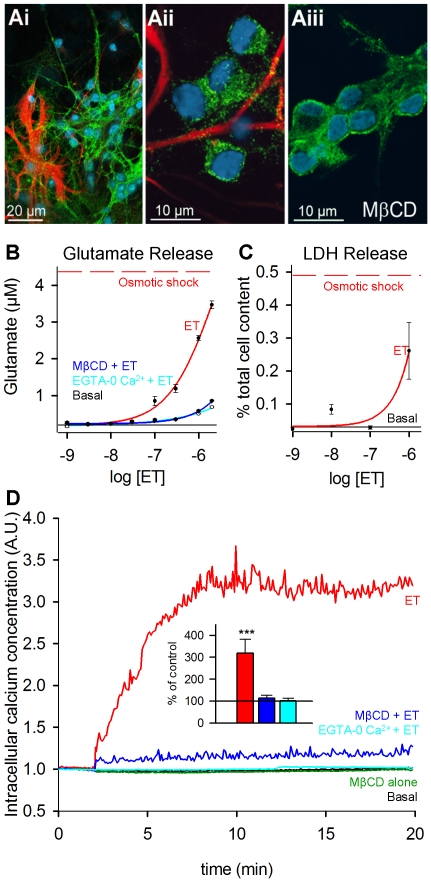
Effect of ET on primary cultures of cerebellum highly enriched in granule cells.Ai, Aii and Aiii, primary cultures of cerebellar cells. Ai and Aii, 10−7 M ET was applied in PBS buffer (i.e. containing no Ca2+ ions) for 5 min after fixation of the cells, then the ET- (green) and GFAP-(red) immunoreactivities were revealed. Cell nuclei were labeled using DRAQ5 (cyan). GFAP-positive cells (astrocytes) are not labeled by ET. Aiii, same kind of experiment except that the culture was pretreated with methyl-β-cyclodextrin (MβCD, 1 mM for 30 min at 37°C) before fixation. B, the glutamate concentration (µM) in extracellular medium was determined from cerebellar primary cultures using the Amplex Red Assay. ET was applied for 10 min at the indicated final concentrations, under the following conditions: ET alone (red) ET after pretreatment with methyl-β-cyclodextrin (blue), ET in physiological medium containing no Ca2+ (10 mM EGTA; 0 mM CaCl2; cyan). Data points are mean ± SEM determined from triplicate determinations. C, extracellular lactate-deshydrogenase (LDH) levels (using the Cytotoxicity Detection Kitplus assay). Data points are mean ± SEM (n = 4). In B and C, lower black horizontal lines denote basal levels (i.e. without ET), and upper dashed red lines denote the maximal values determined after granule cell lysis was induced by hypo-osmotic shock. D, averaged Fura-2 measurements of intracellular [Ca2+] from 25 granule cells, in absence (black, denoted as Basal)) or after addition of 10−7 M ET (red), with ET after preincubation of the cells with methyl-β-cyclodextrin (1 mM for 30 min, blue), or with medium containing 10 mM EGTA-0 mM Ca2+ (cyan). The green curve shows control cells preincubated only with methyl-β-cyclodextrin. Inner graph: relative [Ca2+] changes (% of control) determined 10 min after addition of ET in absence (red, n = 15) or presence of methyl-β-cyclodextrin (blue, n = 5) or in EGTA-0 Ca2+ medium (cyan, n = 14). ET vs control: p<0.001, ET + MβCD vs control or MβCD alone: n.s.